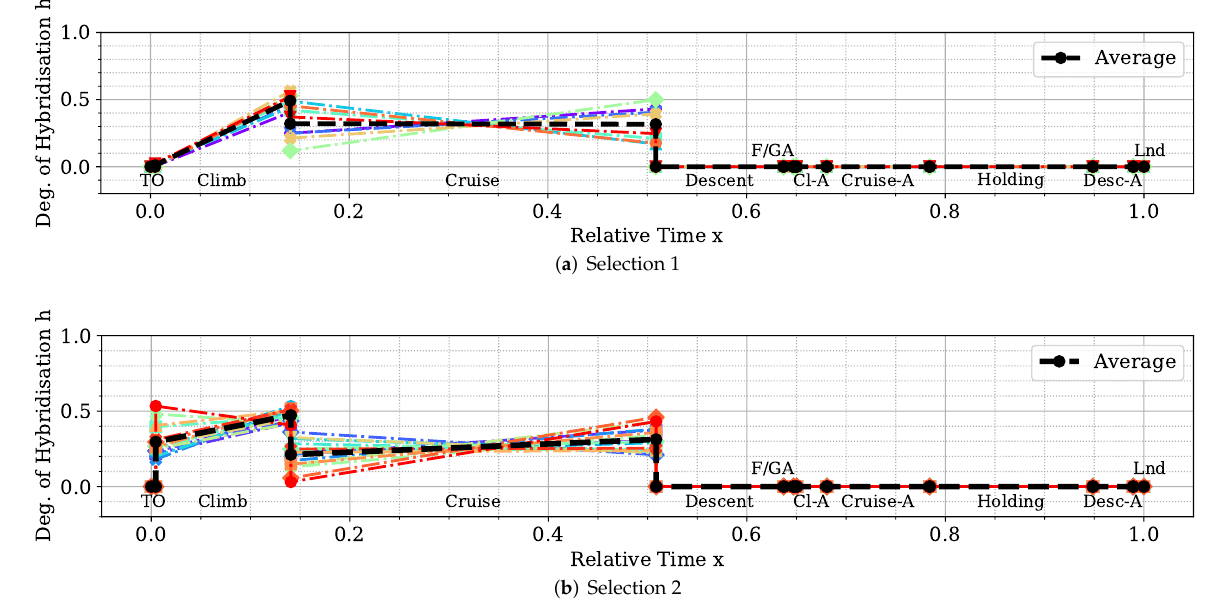
Figure 18. Visualisation of Experiment 6 energy management